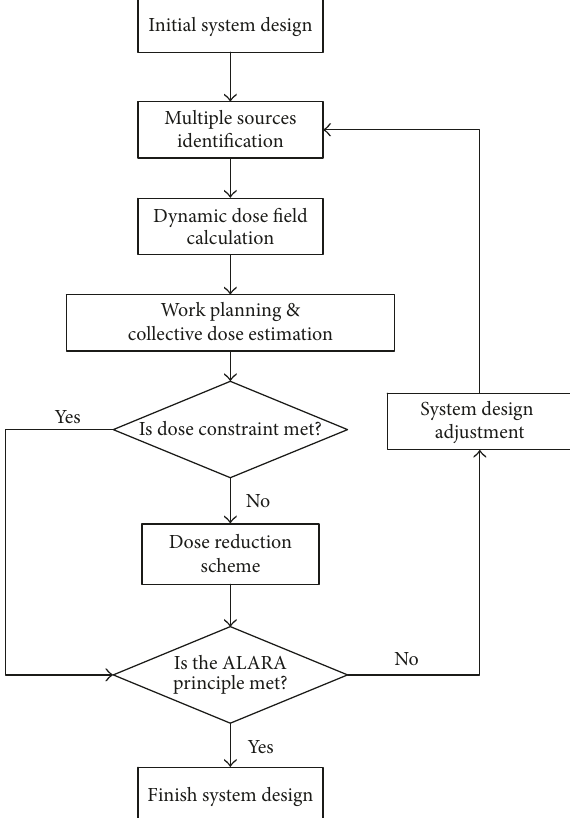
Figure 2: Flowchart of the radiation protection optimization rou- tine for